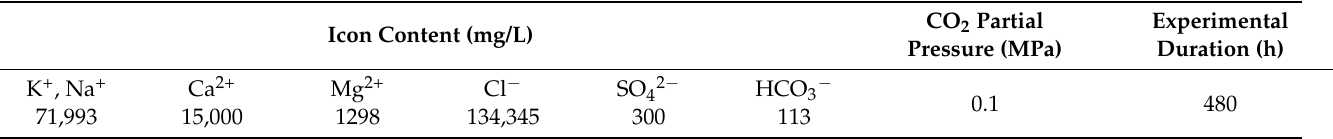
Table 12. Simulated solution of the oil field.